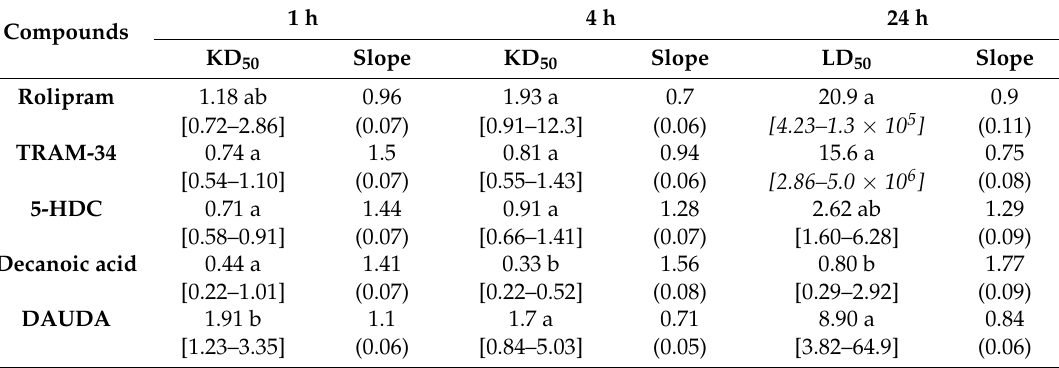
Table 2. Activity of each compound topically applied to adult female An. gambiae . KD 50 and LD 50 values with [95% CIs] are in µ g/mg of adult body weight. Values for response slope ( ± SEM) are also shown. Responses were compared to each other according to the 95% CI of the KD 50 or LD 50 . For each time point (column), different letters mean non-overlapping 95% CI, and KD 50 or LD 50 values not labeled by the same letter are different ( p < 0.05). NB: for rolipram and TRAM-34, mortality failed to reach 50%, so LD 50 values were extrapolated values from the probit analyses and indicated in italics. 1 Compounds